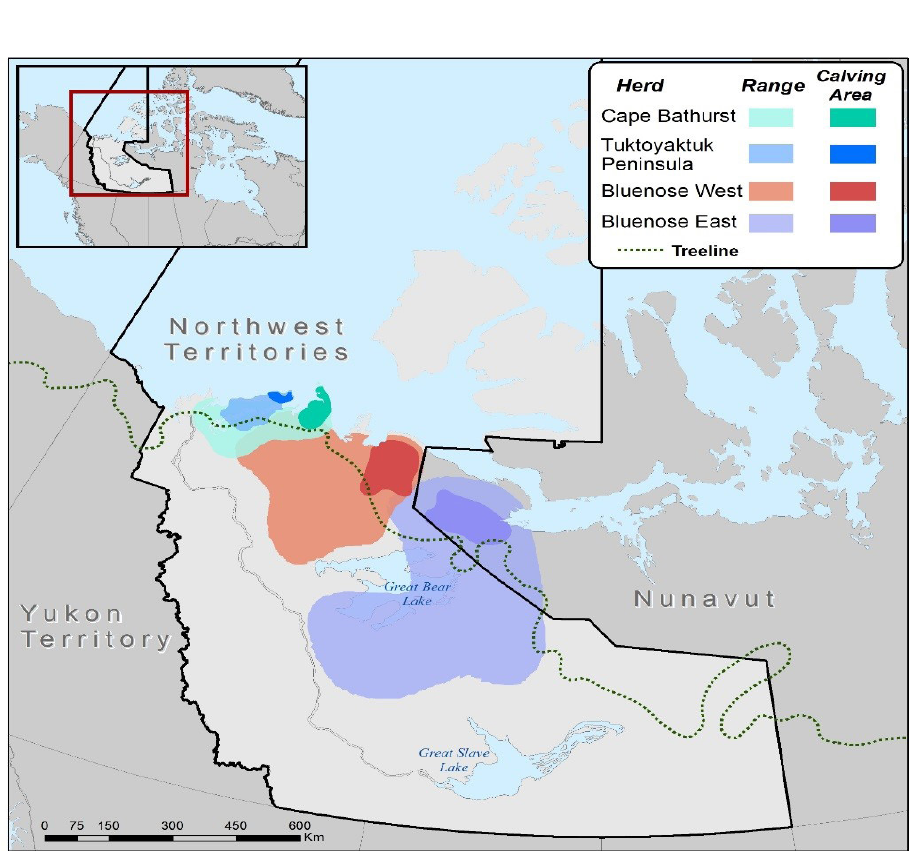
Figure 1. Annual ranges of the caribou herds whose post calving survey data were used in this study. The majority of the herds occurred in Northwest Territories with some overlap of the Bluenose East into Nunavut,